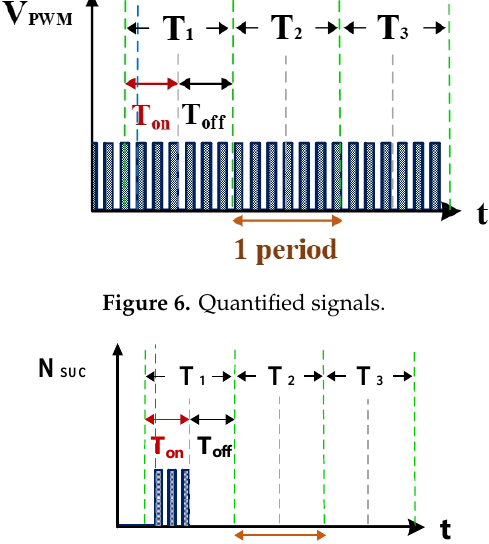
Figure 5. Gap electrical discharge simulation.